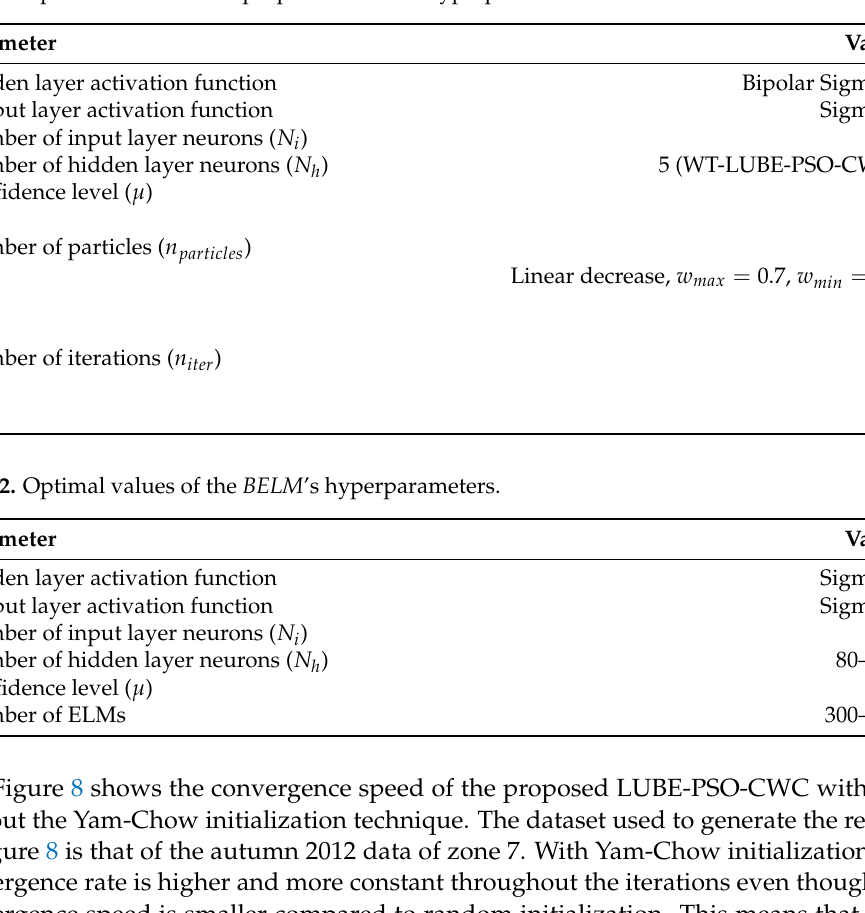
Table 1. Optimal values of the proposed model’s hyperparameters.